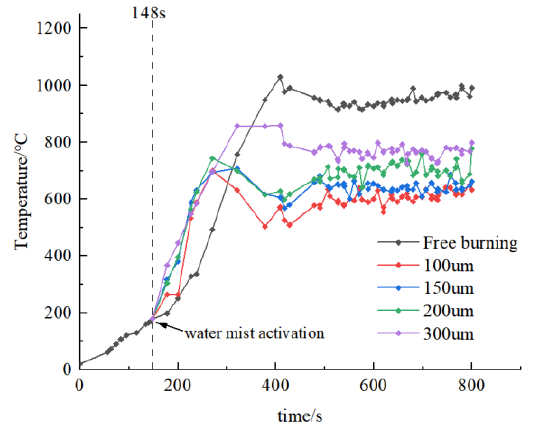
Figure 2. Temperature values measured by thermocouple A at different droplet sizes. The temperature profile of the center of the flame (480 s) after the fire field begins to burn steadily at different droplet sizes is shown in Figure 3. The temperature values extracted at 200, 400, 600, and 800 s are shown in Table 4.